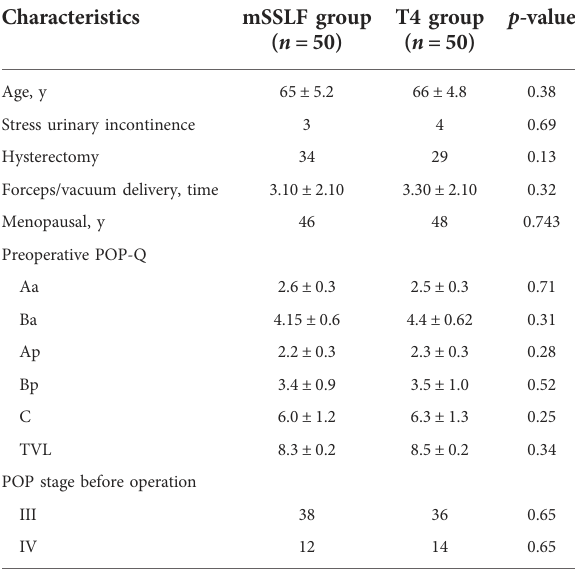
TABLE 1 Characteristics of the study patients ( n =100). a